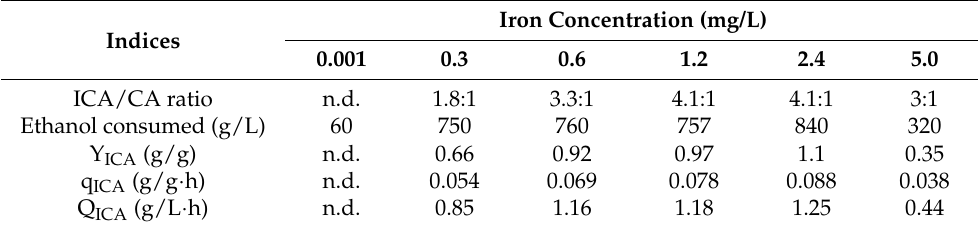
Table 3. Effect of iron concentration on indices of ICA production by Y. lipolytica VKM Y-2373. Indices